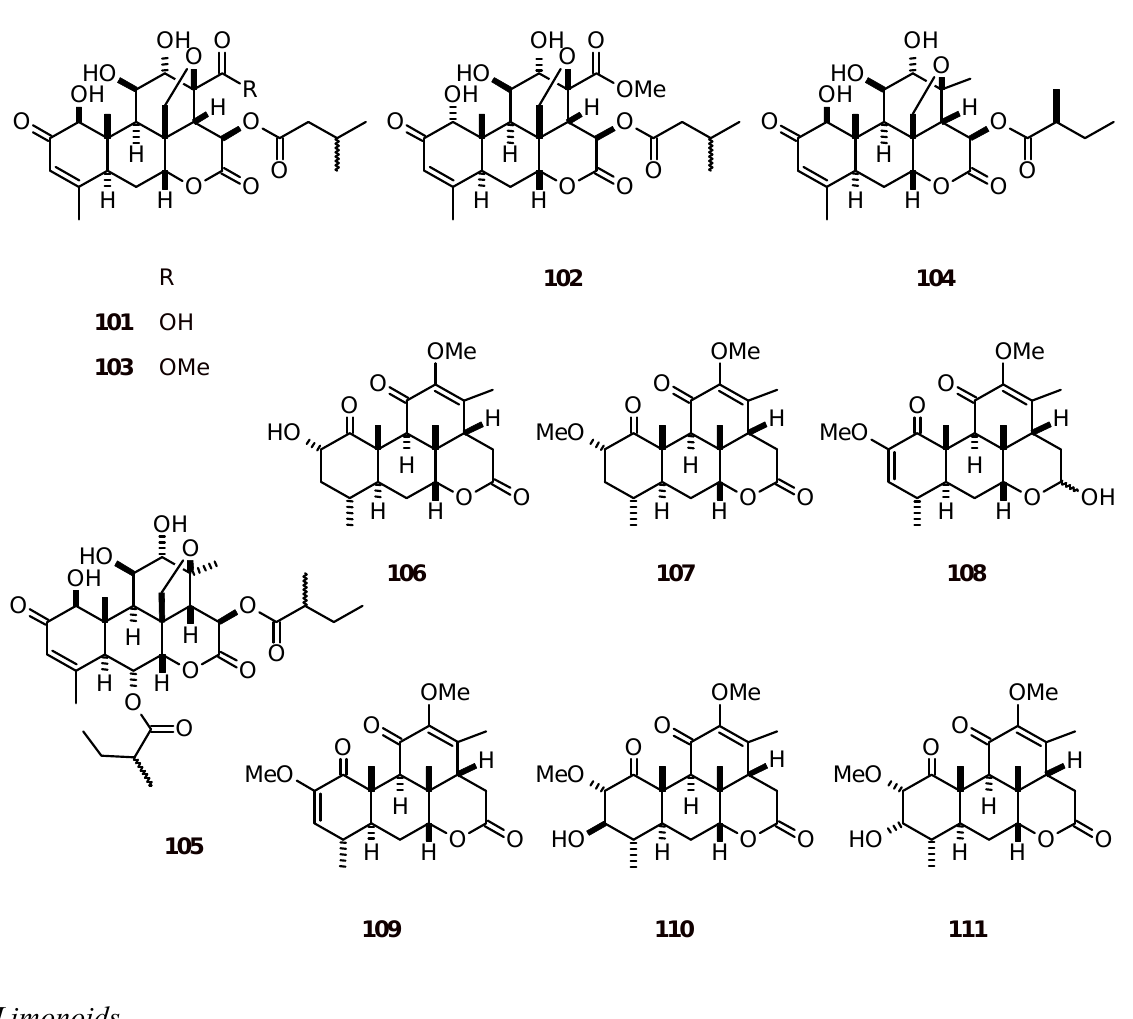
Figure 11. Structures of quassinoids 101 - 111